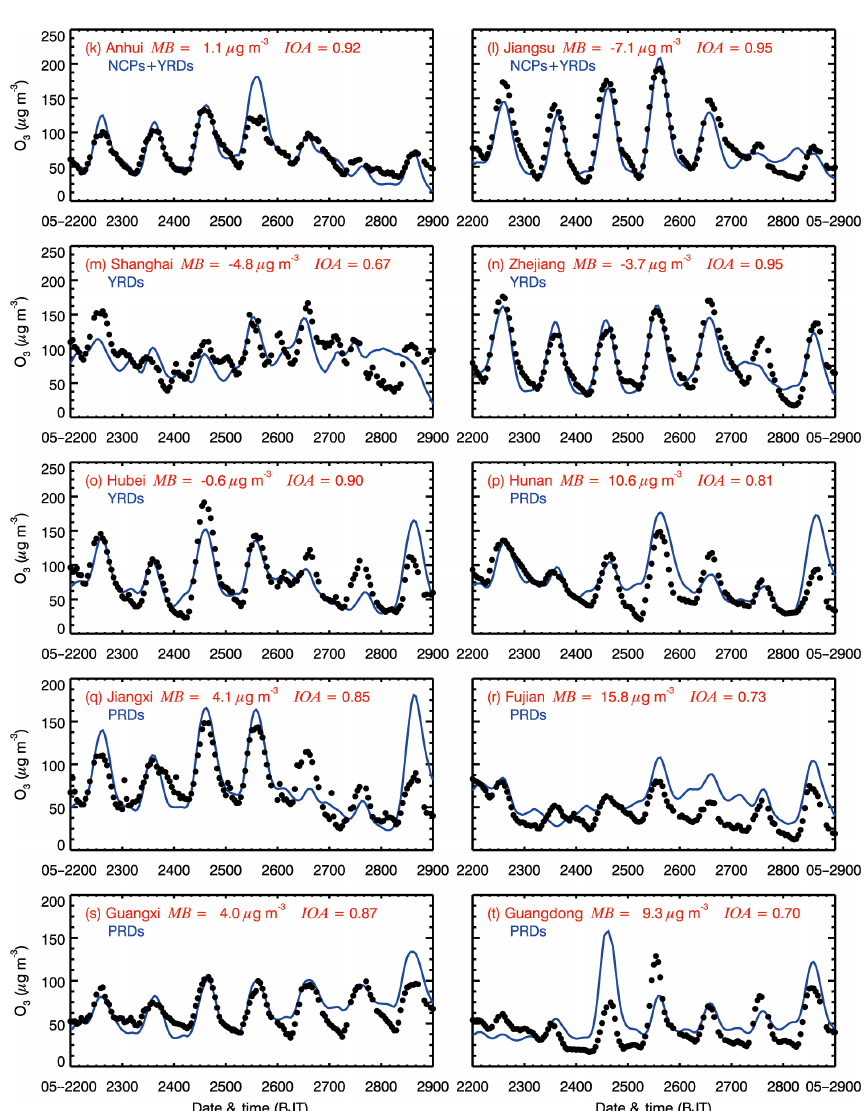
Figure 7. Comparison of measured (black dots) and predicted (blue line) diurnal profiles of near-surface O 3 averaged over all ambient monitoring stations in provinces of eastern China from 22 to 28 May